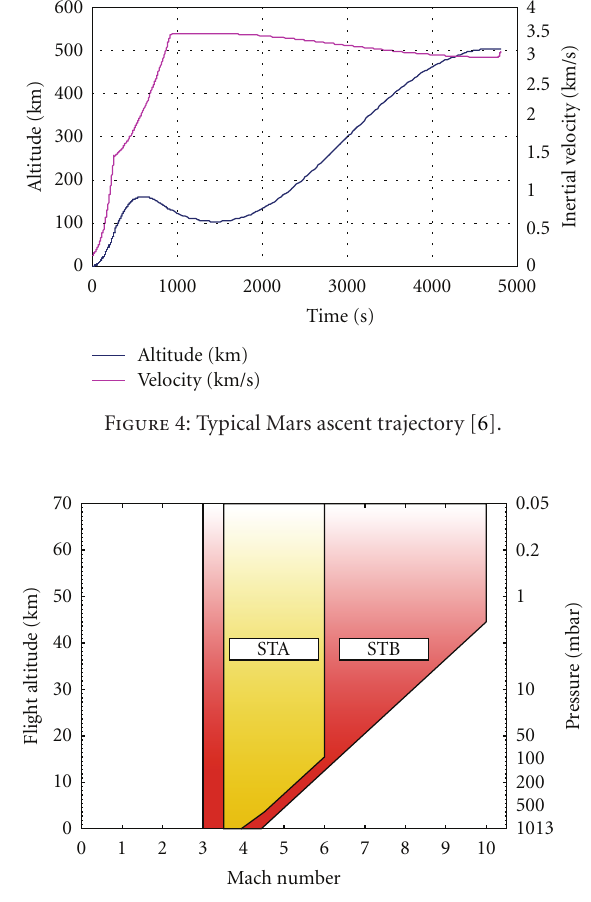
Figure 5: Capabilities of ISL shock tubes STA and STB (credit